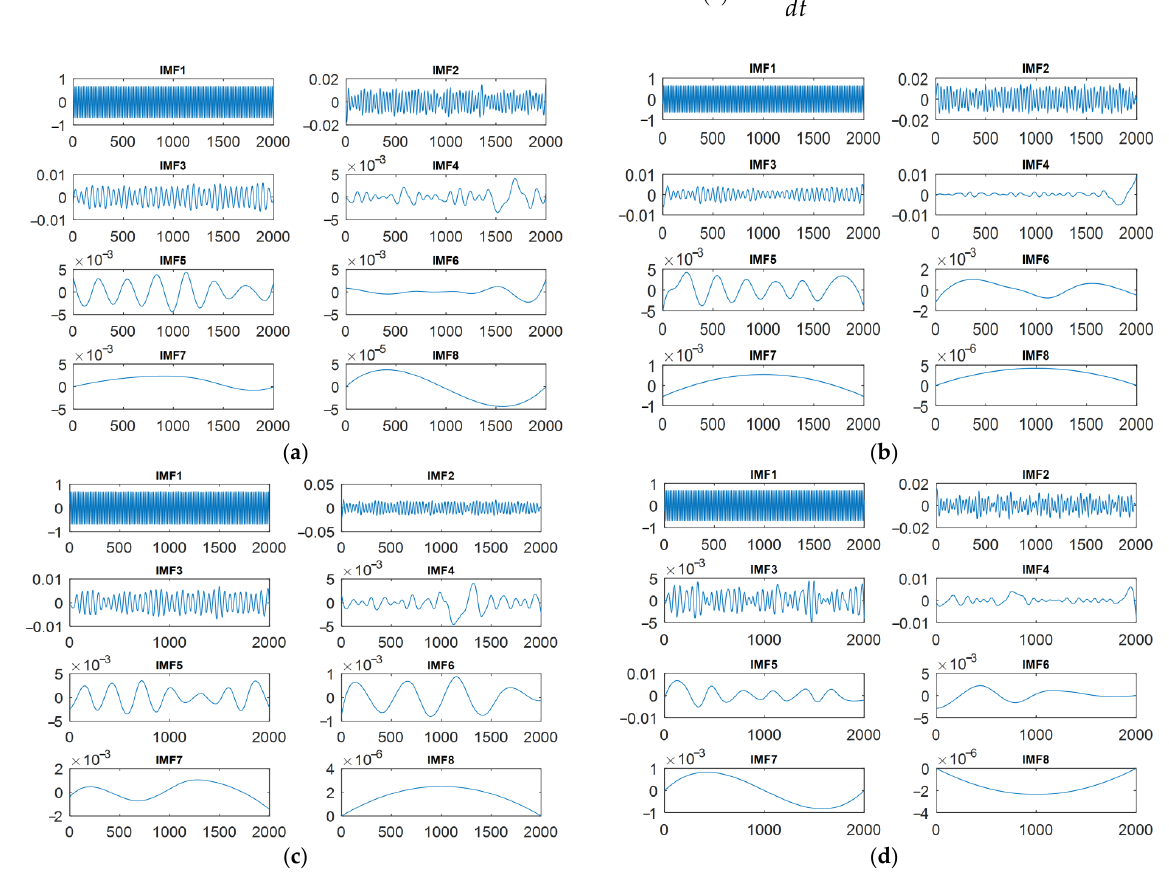
Figure 2. ( a ) The IMF waveform of normal motor, ( b ) the IMF waveform of broken bearings motor, ( c ) the IMF waveform of a broken rotor bar motor, ( d ) the IMF waveform of a stator winding short-circuit motor.